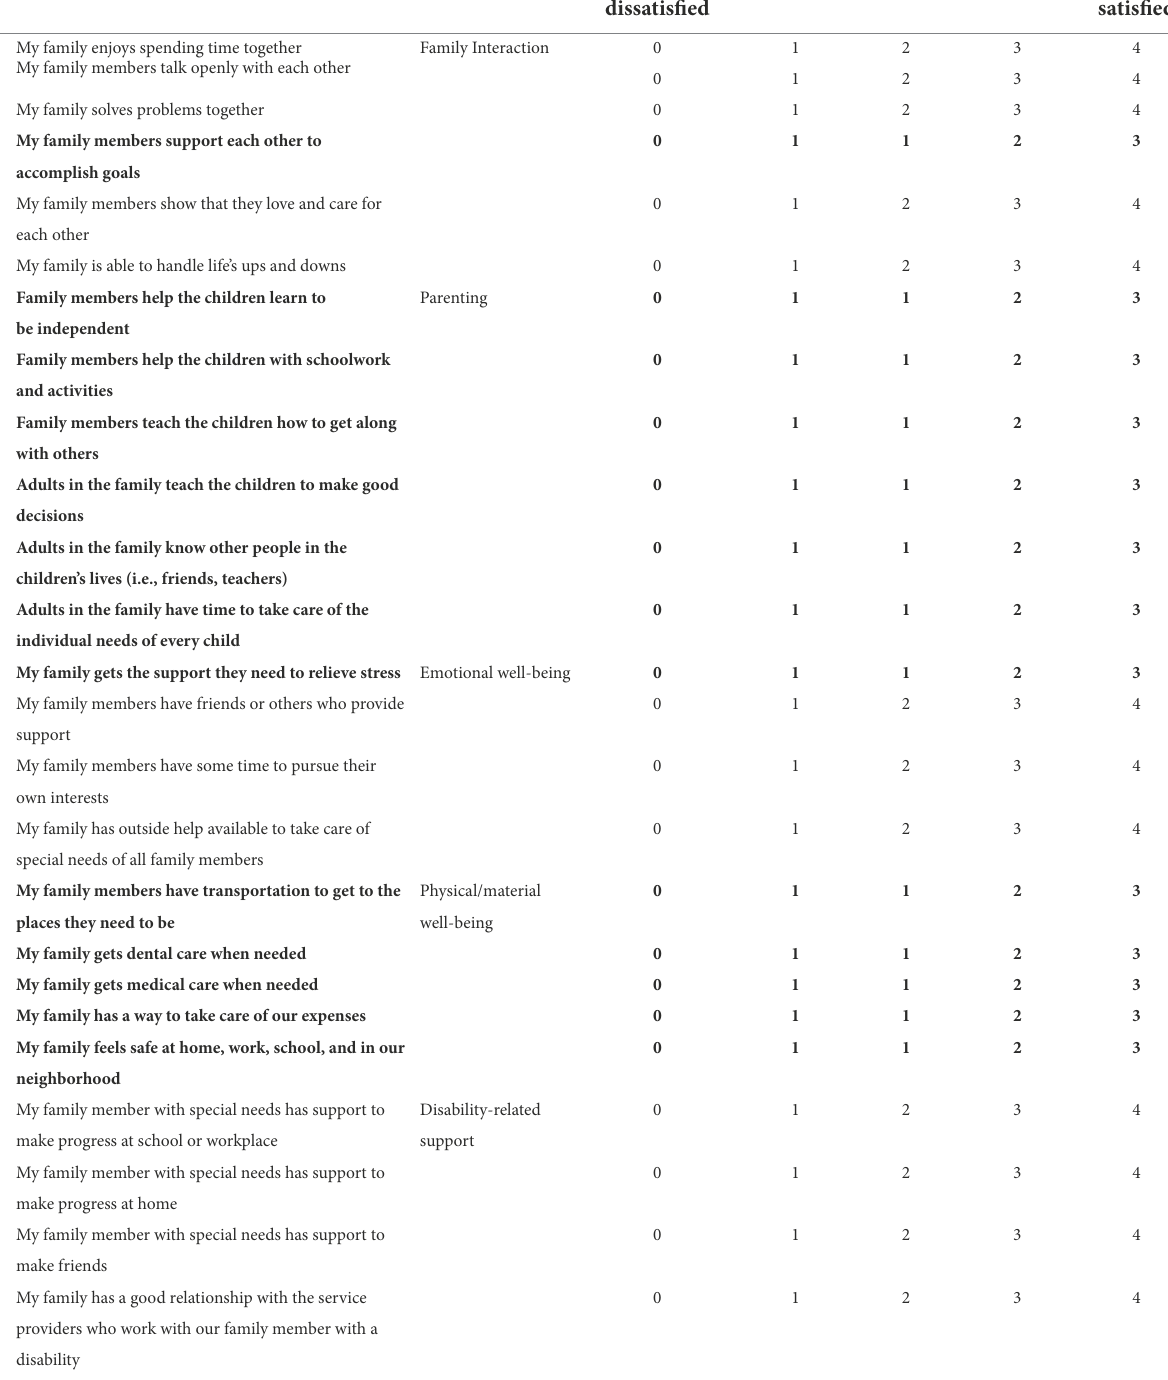
TABLE 2 The final Rasch-validated